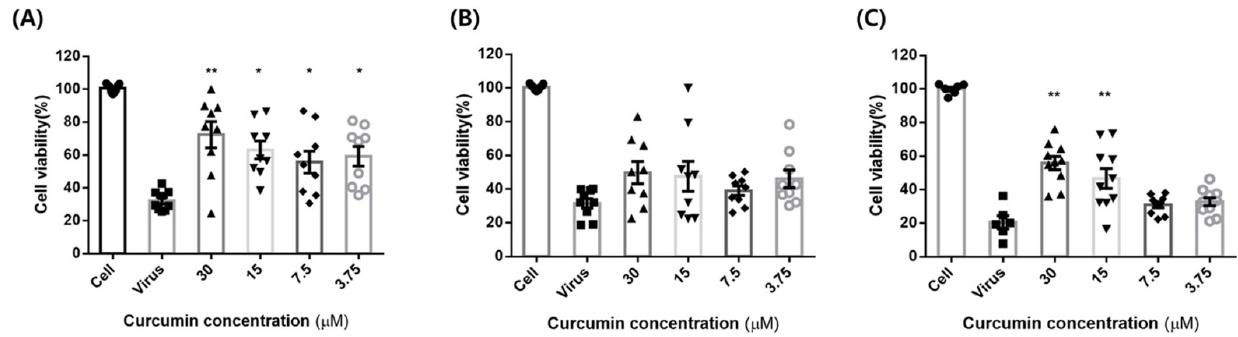
Figure 6. Curcumin cytopathic effect (CPE) test. MDCK cells were treated with influenza virus (100TCID50) with or without different concentrations of curcumin (3.125–30 µM): ( A ) pre-treatment: MDCK cells were pre-treated with different concentrations of curcumin for 1 h at 37 °C and then infected with influenza virus for 48 h to determine curcumin’s prophylactic effect; ( B ) co-treatment: MDCK cells infected with virus were co-treated with different concentrations of curcumin for 48 h at 37 °C to determine curcumin’s virus binding-inhibitory effect; ( C ) post-treatment: MDCK cells were infected with virus for 1 h and then incubated with curcumin for 48 h at 37 °C to validate whether curcumin exhibits therapeutic effects. ** p < 0.001, * p < 0.05, compared with the virus group; NS, not significant.